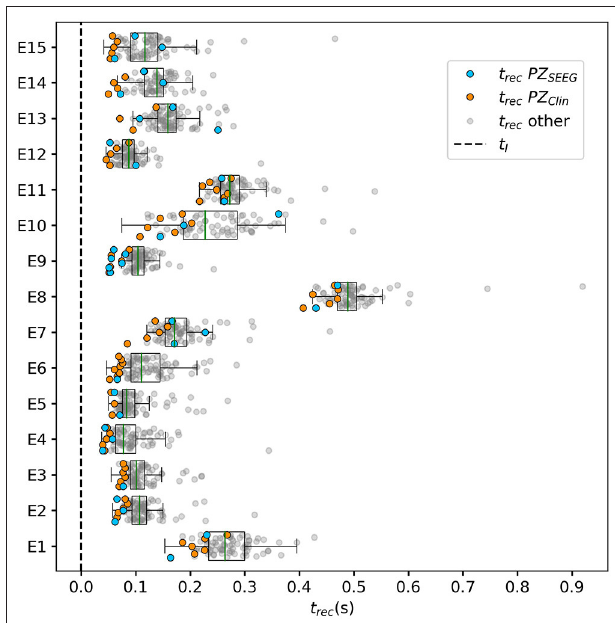
FIGURE 10 | Recruitment times of all brain areas for the cohort of epileptic patients: The recruitment time, reported on the x -axis, identifies the time needed by a brain area to jump to the HA regime after the application of the perturbation current. The boxplots consist of the recruitment times of all brain areas for each patient. Patients are identified according to their numbers on the y -axis. The median is represented as a green vertical line while the boxes contain the second and third quartile of the distribution. The whiskers are chosen with a maximum length of 1.5 IQR (interquantile range) and show × the most extreme observed values that are within 1.5 IQR from the upper or × lower quartiles. The gray dots represent the recruitment times for each brain area. The orange dots show the recruitment of a brain area clinically predicted to be part of the PZ Clin . The blue dots represent the recruitment of a brain area that is part of the PZ according to the SEEG measurements PZ SEEG . η ( k ) η Parameters: N pop 88, 1 1, σ 1.25, I S 10, t I 0.4 s, 7.5 = = = = = ¯ = ¯ = − η η [except for patients E1 ( 6) and E11 ( ¯ = − ¯ = −